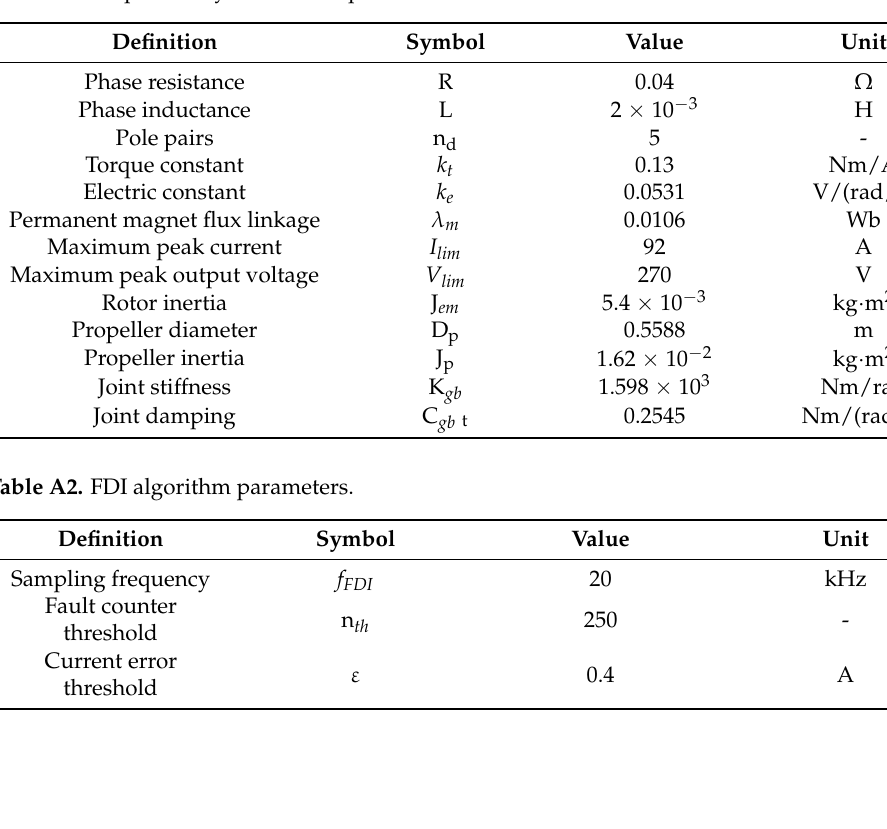
Table A1. Propulsion system model parameters.